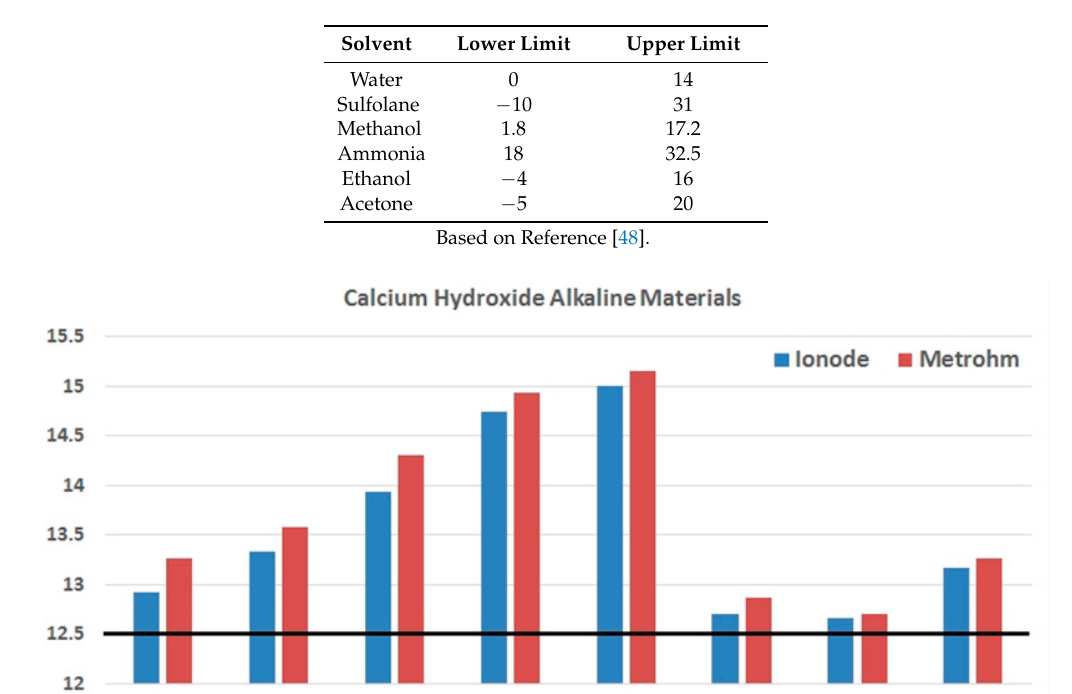
Table 2. pH windows in various solvents.